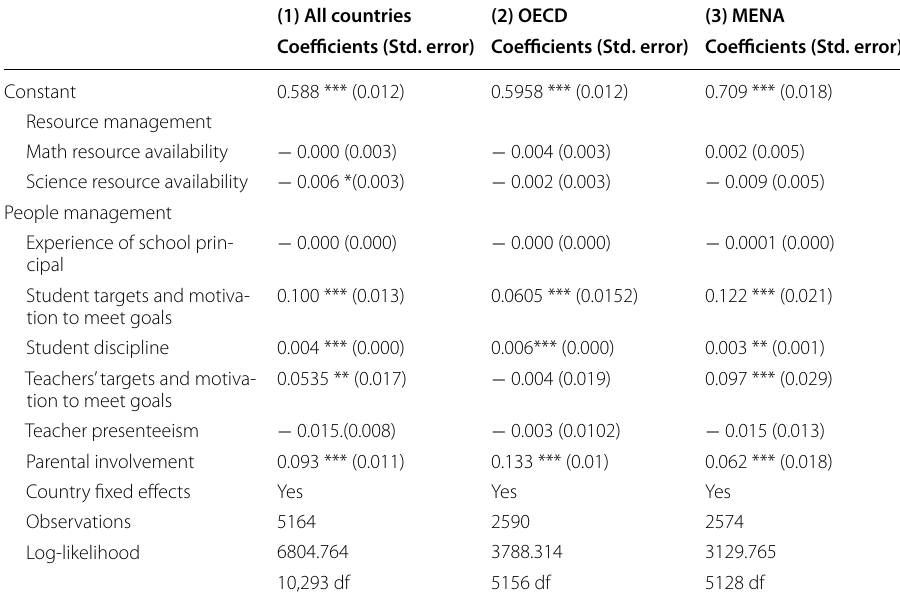
The table reports the estimates of Tobit regression for the entire sample of schools in MENA and OECD countries in TIMSS 2019 with output-oriented technical efficiency taken as the dependent variable * p < 0.1 ** p <